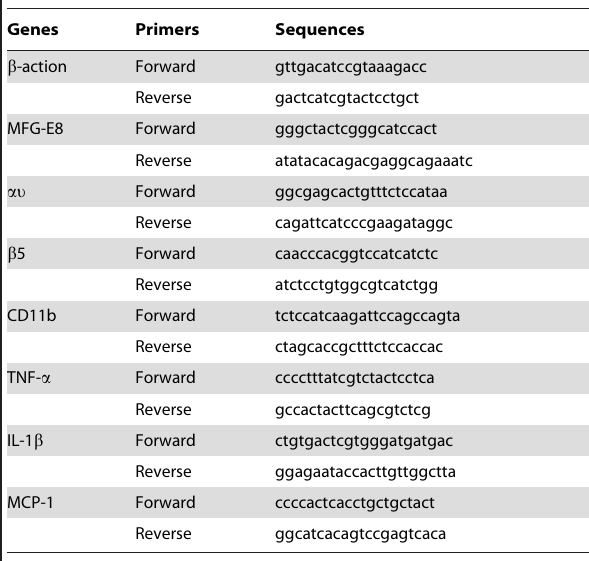
Table 1. Summary of